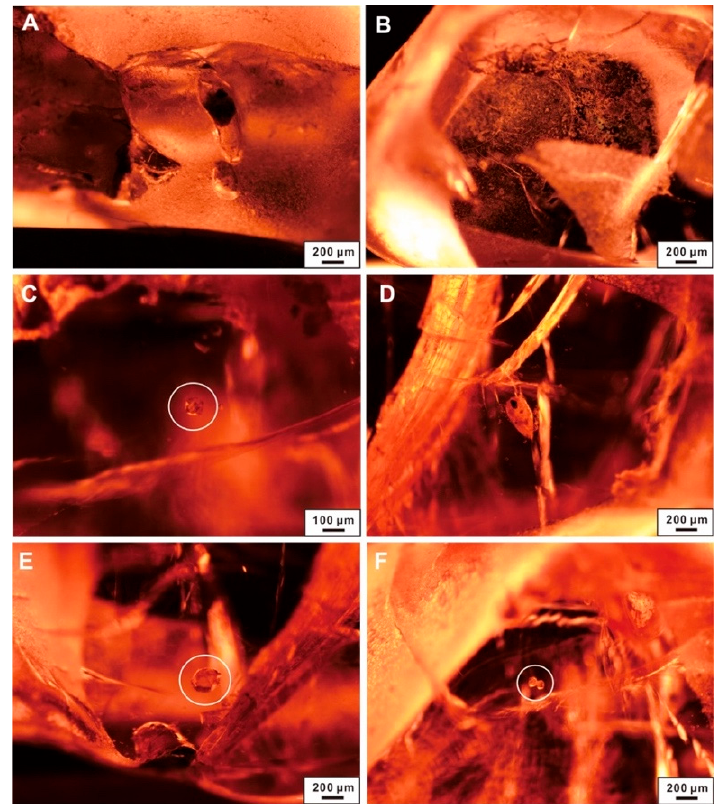
Figure 4. Internal features of Mogok purple and orange spinel samples. ( A ) Gas–liquid inclusions and black lamellar inclusions in purple samples (B-1); ( B ) cloud-like healed fissures in B-1; ( C ) the octahedral crystal in the orange sample (B-2); ( D ) the black inclusion with fluid in the orange sample (B-5); ( E ) hexagonal plate-like inclusions in B-5; ( F ) joined octahedral crystals in B-2. Pink spinel samples also contain octahedral inclusions (Figure 5A), as well as many fine microgranular inclusions (Figure 5B). Due to the low transparency of the red spinel samples, the internal inclusions cannot be clearly observed, only the remnants of octahedral inclusions and disk-like fissures can be seen (Figure 5C,D).